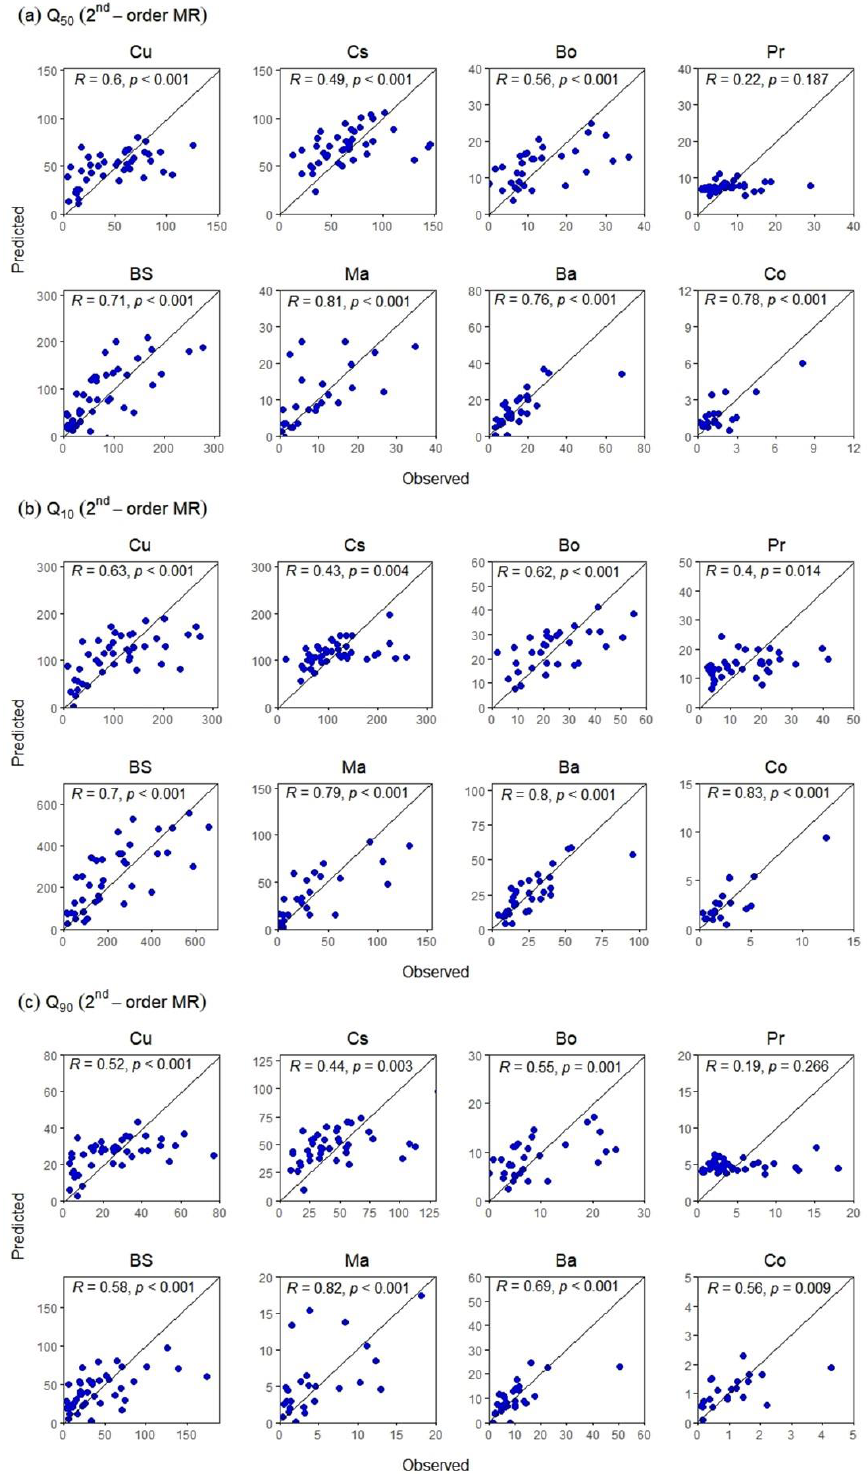
Figure A1. Scatterplots between the predicted (Niño 3.4-DMI, second-order MR, SON a set) and the observed values (in m 3 /s) of the flow regimes ( a ) Q 50 , ( b ) Q 10 , and ( c ) Q 90 for all rivers in this